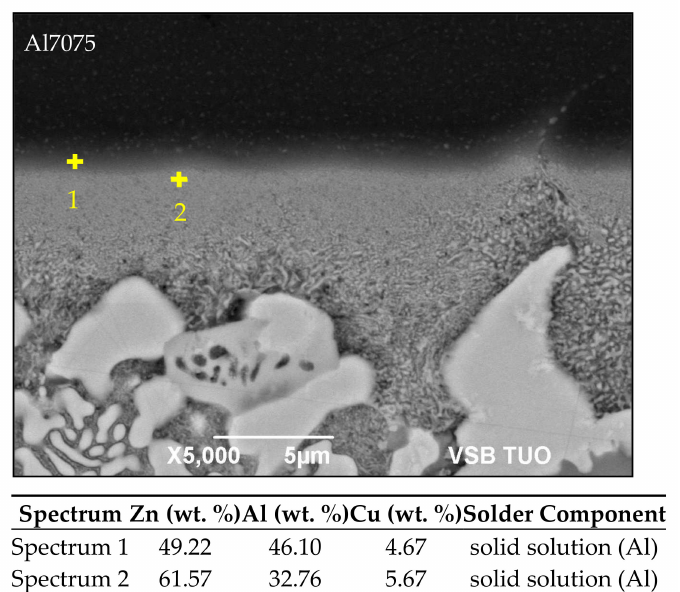
Figure 14. A detail of the boundary in Al7075/Zn5Al3Cu joint.